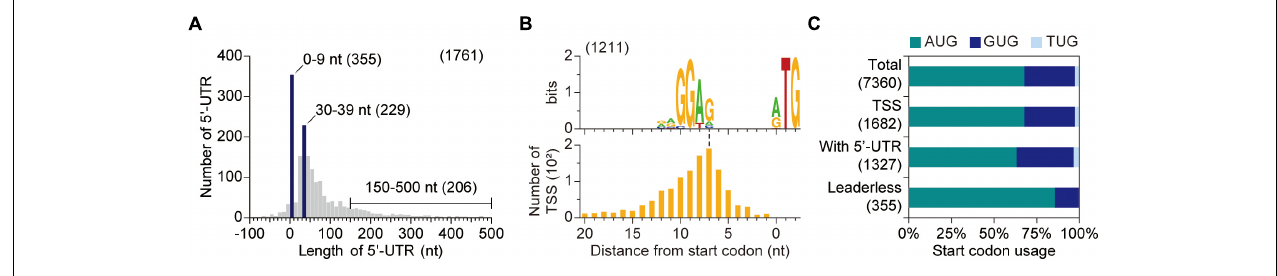
FIGURE 3 | Determination of 5 (cid:48) -UTR. (A) The distribution of 5 (cid:48) -UTR length. Only primary transcription start sites assigned to coding DNA sequences were considered. (B) Conserved ribosome binding site (RBS) sequences of S. lividans . RBS sequence was discovered using up to 25 nt sequences upstream of start codon when the 5 (cid:48) -UTR is longer than 10 nt. (C) Start codon preference dependent on 5 (cid:48) -UTR length. AUG is preferred as a start codon for leaderless